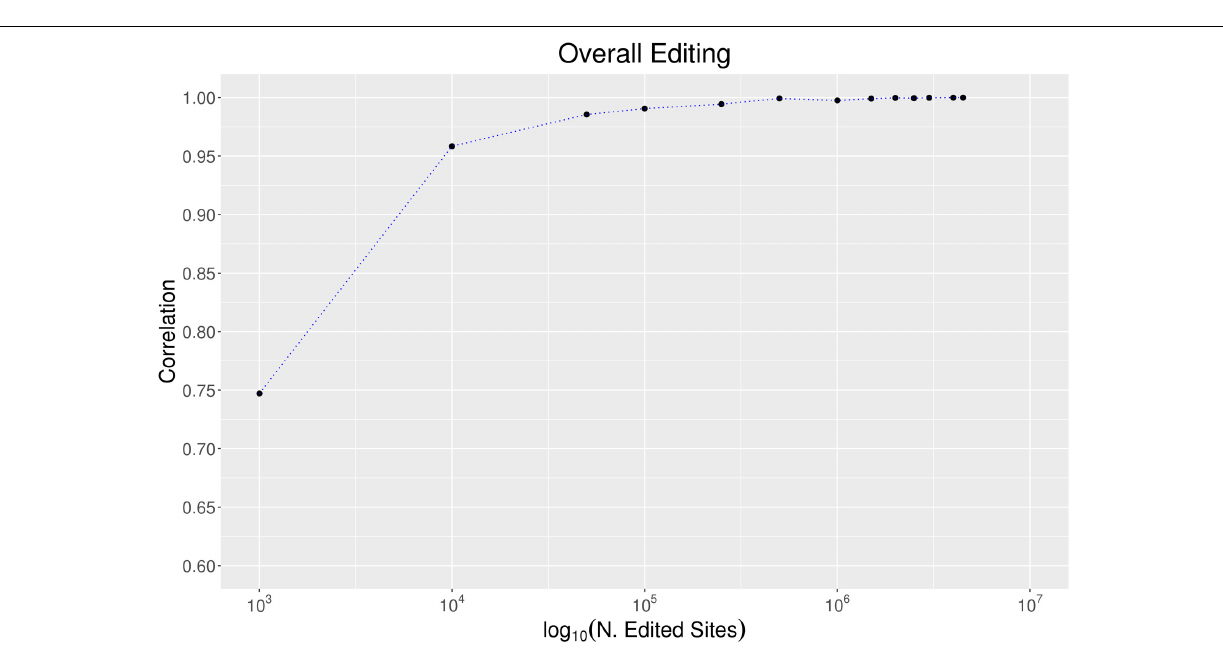
FIGURE 6 | The effect of the number of sites on the overall editing. We calculated the overall editing calculated in all 123 GTEx samples using a growing number of positions randomly selected from REDIportal database. The Pearson correlations between the overall editing measured per each group of positions and the same metric on the entire REDIportal collection are